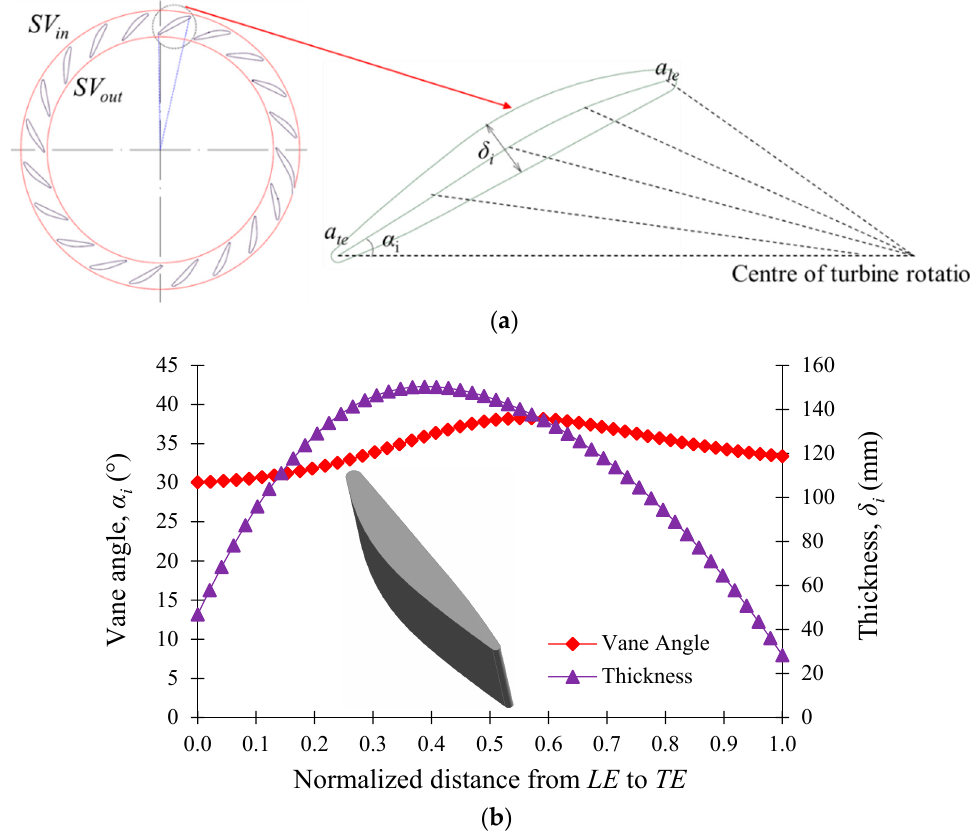
Figure 3. ( a ) Parametric design schematic view and ( b ) initial stay vane shape.